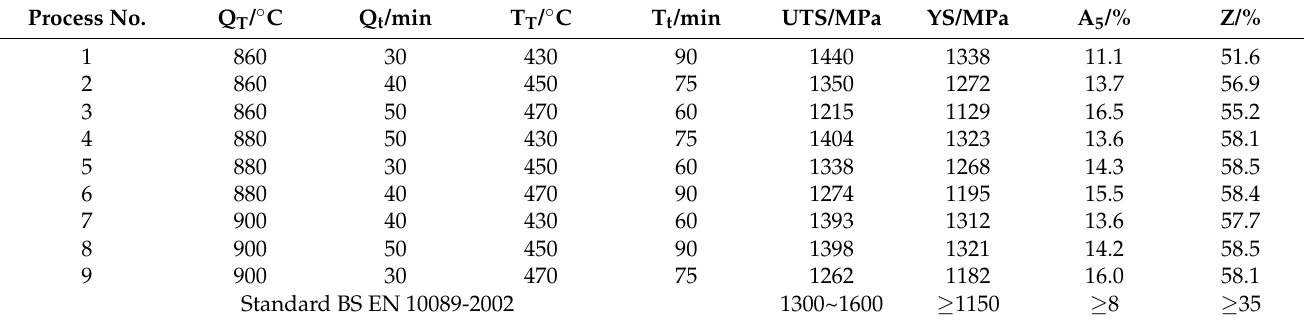
Table 2. The orthogonal tables L9 (3 4 ) and mechanical properties of 38Si7spring steel.